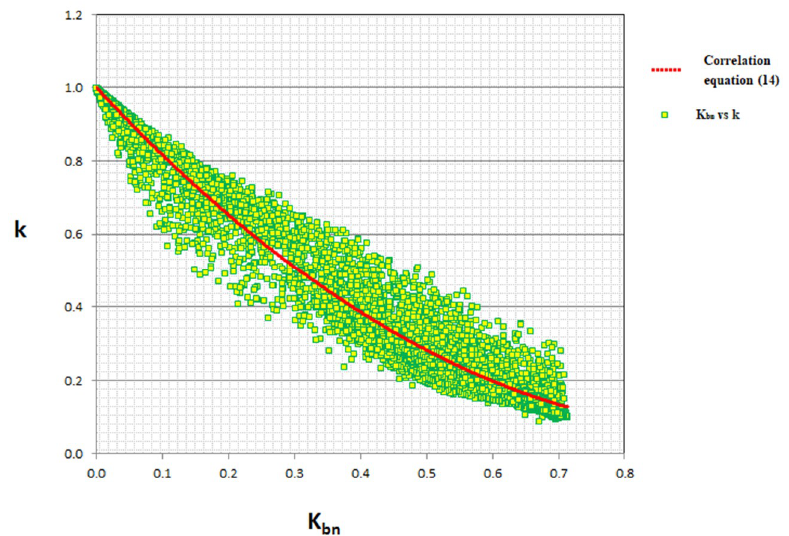
Figure 8. Dispersion graphs of hourly parameter pairs ( K bn , k ), where and K bn is the transmission coefficient for normal direct radiation and k is the fraction of the diffused radiation with respect to global radiation with their correlation Equation (14) (in red).